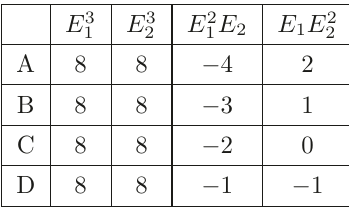
For the prepotential for SU(3) gauge theory with n f = 0 and CS level k , we